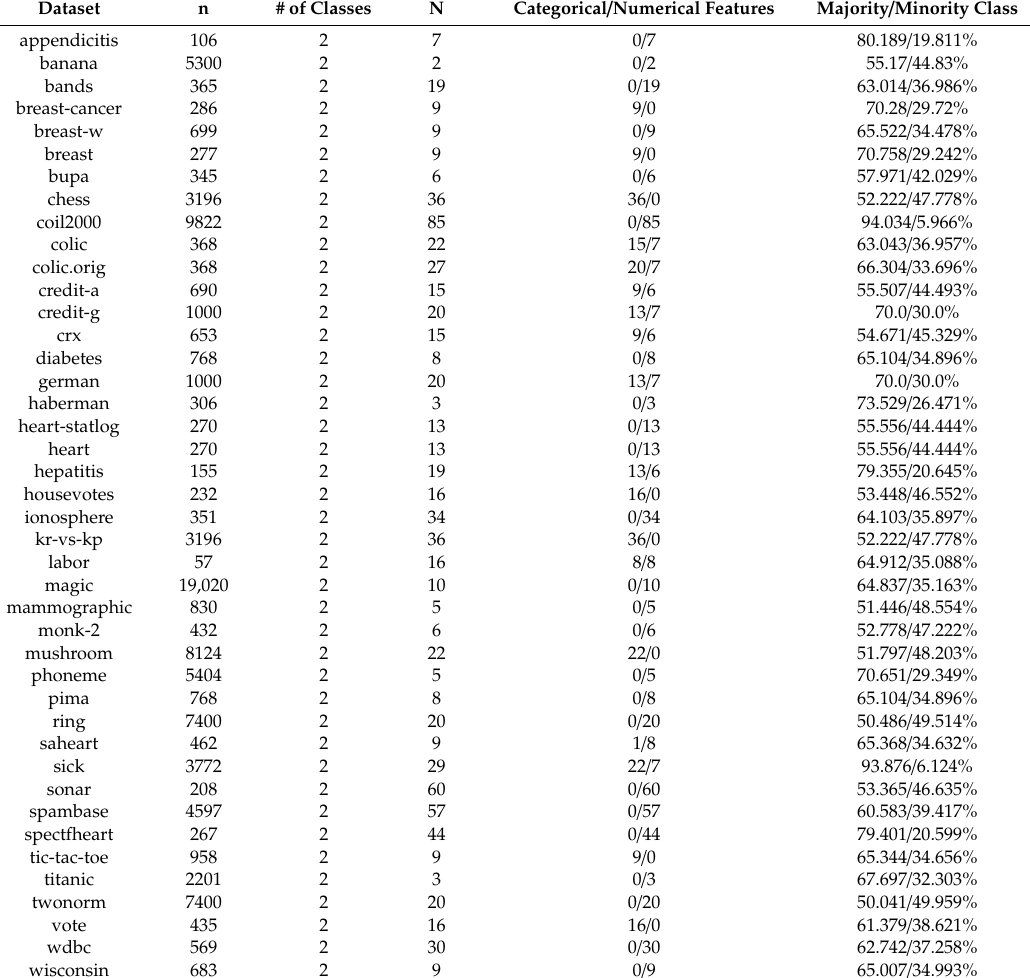
Table 1. Formulation of the examined binary class datasets.